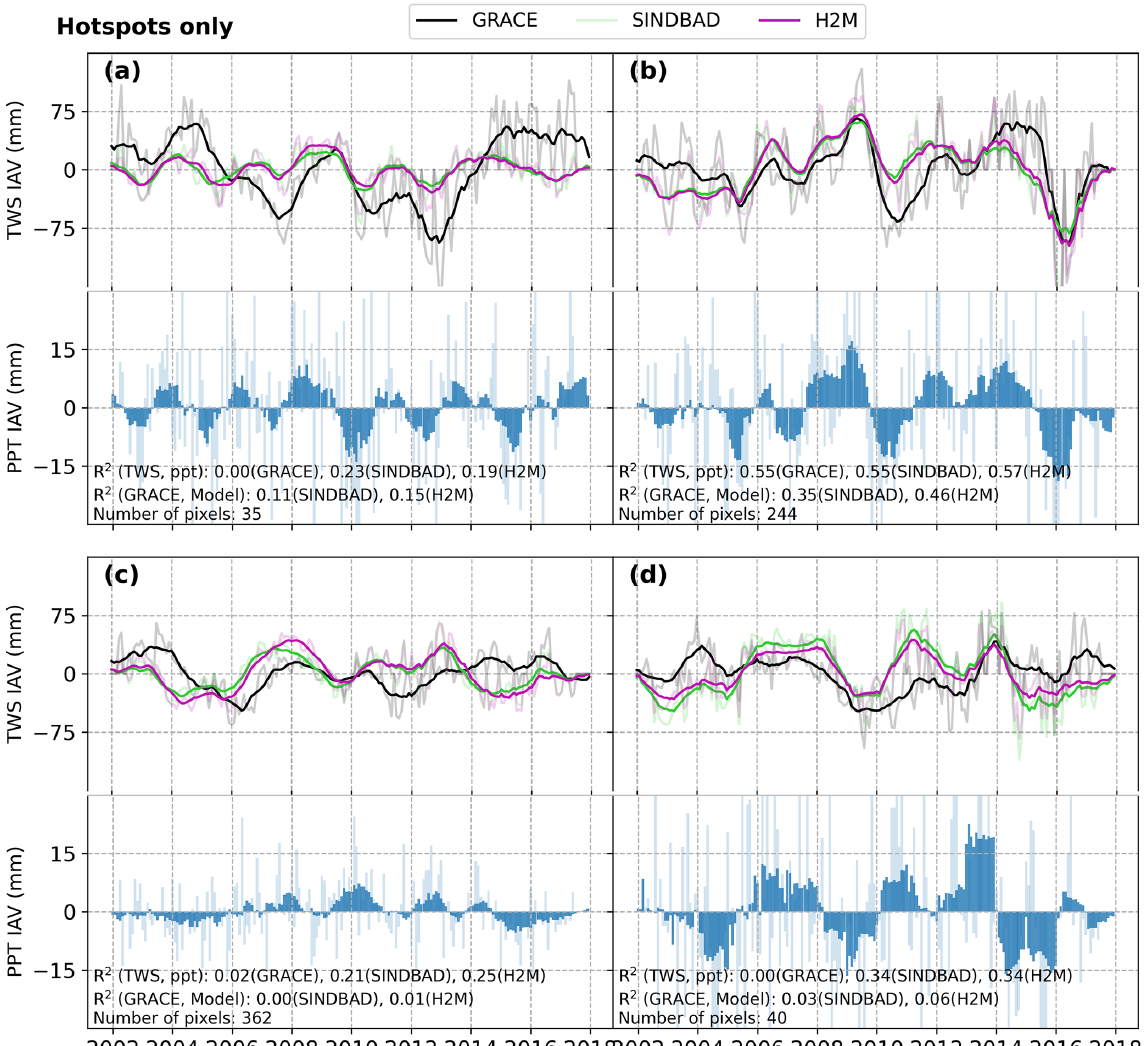
Figure B11. Same as Fig. 6 but using MSWEP instead of GPCP1dd for PPT IAV.